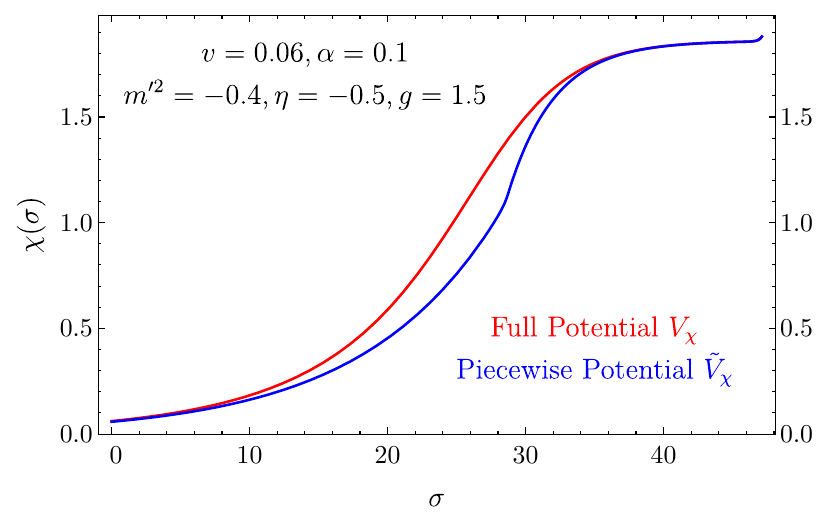
Figure 3. The profile of Goldberger-Wise scalar χ ( σ ) from two different potentials: full potential eq. (5.5) and simplified potential eq. (5.9) . The parameters we choose are m 0 2 = − 0 . 4 , η = − 0 . 5 , g = 1 . 5 and v =0.06, α = 0 . 1 and L = 15 π